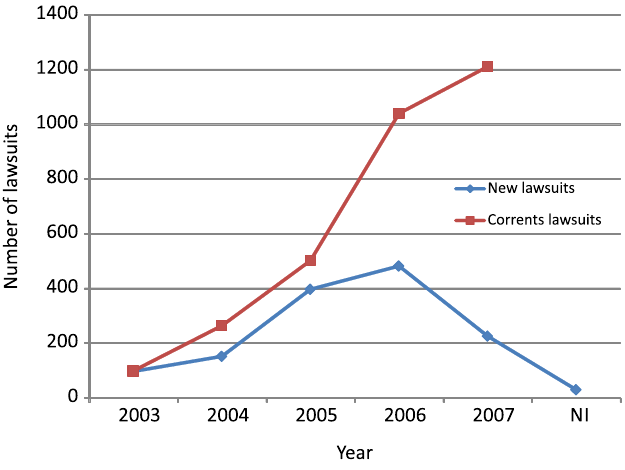
FIGURE 1 - Number of new lawsuits filed against the Municipal Health Secretariat and number of current lawsuits (year not given in 29 lawsuits), 2003-2007, Goiânia – GO.